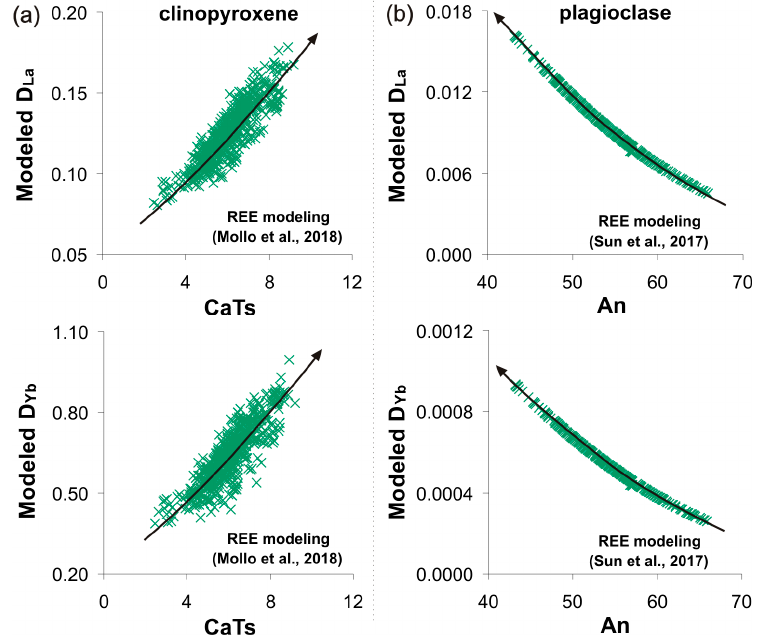
Figure 11. The partition coefficients of La (D La ) and Yb (D Yb ) have been modeled as a function of clinopyroxene ( a ) and plagioclase ( b ) geochemical evolution along with the decompression and cooling path of the sill magma. CaTs and An refer to Ca-Tschermak and An components. The partitioning data have been modeled through the lattice strain equations of Reference [62] and Reference [130] specific to clinopyroxene and plagioclase, respectively. See Table S6 submitted as supplementary material.